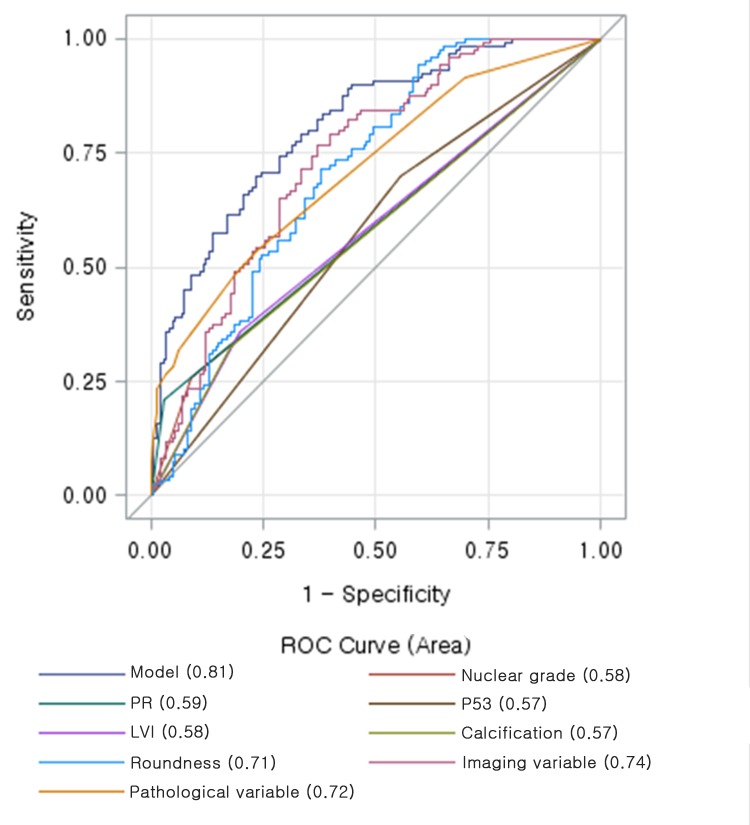
Receiver-operating characteristic curve determined by multivariate logistic regression analysis for distinguishing low recurrence scores from high or intermediate recurrence scores: tumour roundness, absence of calcification in the mass, lymphovascular invasion, PR positivity, nuclear grade, and p53 are predictors of recurrence.Data in parentheses indicate the Az values for the each variables.